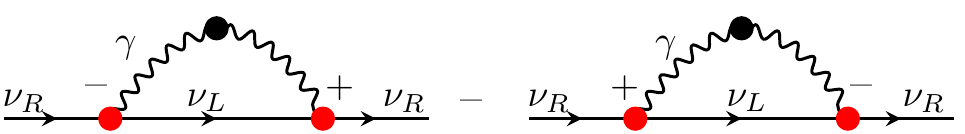
Figure 3 . Two contributions, Σ − + ( p ) and Σ + − ( p ) , to the imaginary part of the retarded right- handed neutrino self-energy. The black blob denotes the charged-fermion loop in the resummed photon propagator, as shown in figure